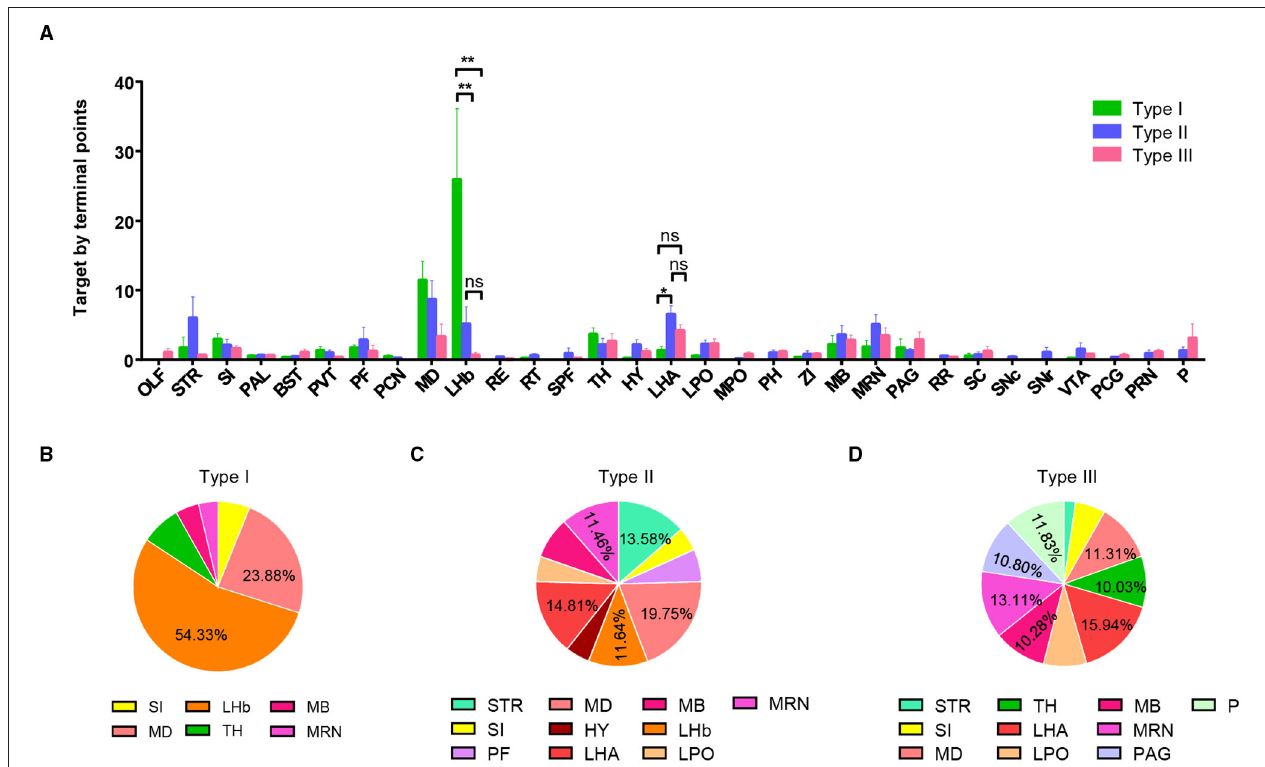
FIGURE 3 | Quantification of projection of VP neurons in the whole brain. (A) Projection intensity of three types of VP neurons in the whole brain (** P < 0.01). (B–D) Pie charts showing a preference of projection intensity pattern in the whole brain for type I neurons (B) , type II neurons (C) , and type III neurons (D) . ns, no significant correlations; OLF, olfactory area; SI, subtantia innominate; BST, bed nuclei of the stria terminalis; PVT, paraventricular nucleus of the thalamus; PF, parafascicular nucleus; PCN, paracentral nucleus; LHb, lateral habenula; RE, nucleus of reuniens; RT, reticular nucleus of the thalamus; SPF, subparafascicular nucleus; LHA, lateral hypothalamic area; LPO, lateral preoptic area; MPO, medial preoptic area; PH, posterior hypothalamic nucleus; ZI, zona incerta; MRN, midbrain reticular nucleus; PAG, periaqueductal gray; RR, MB reticular nucleus, retrorubral area; SC, superior colliculus; SNc, substania nigra, compact part; SNr, substantia nigra, reticular part; VTA, ventral tegmental nucleus; PCG, pontine central gray; PRN, pontine reticular